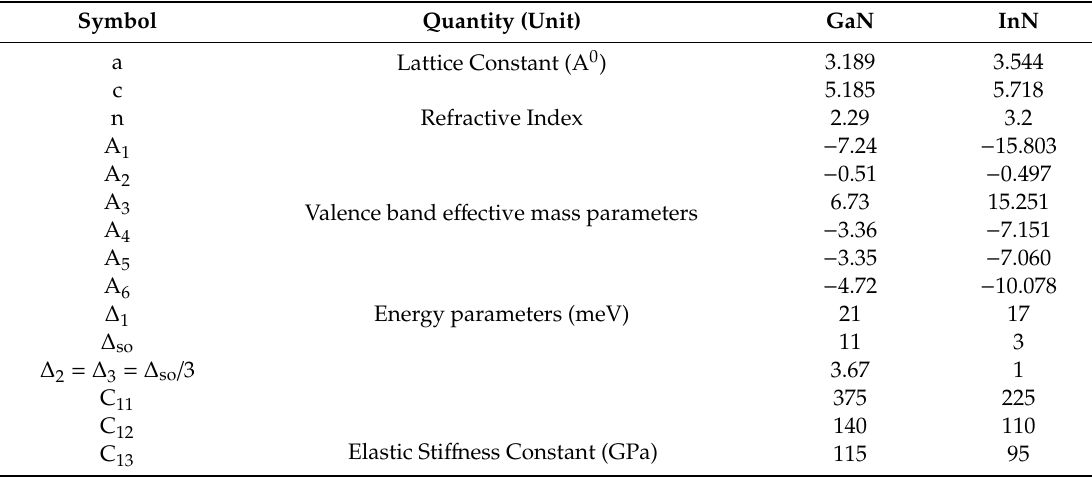
Table 1. Key Parameters for GaN and